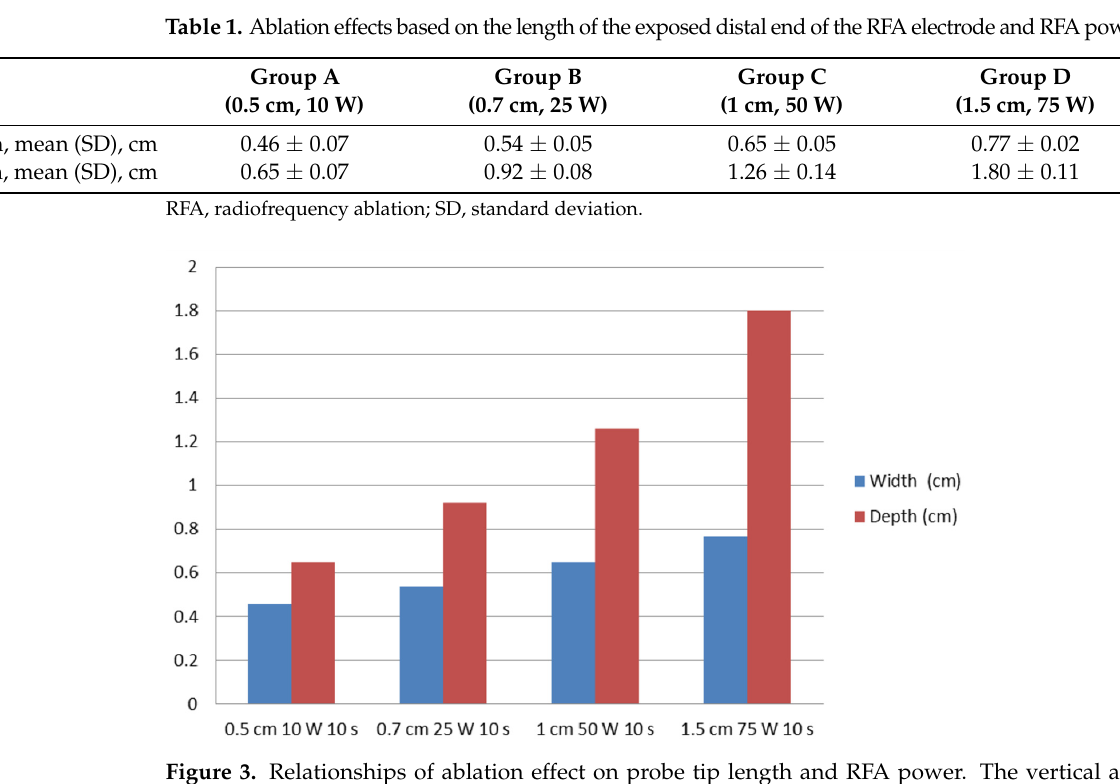
Figure 4. Comparison of ablation zones based on the ablation power and ablation time. ( A ) 1 cm, 30 W, 10 s ( B ) 1 cm, 30 W, 15 s ( C ) 1 cm, 50 W, 10 s.